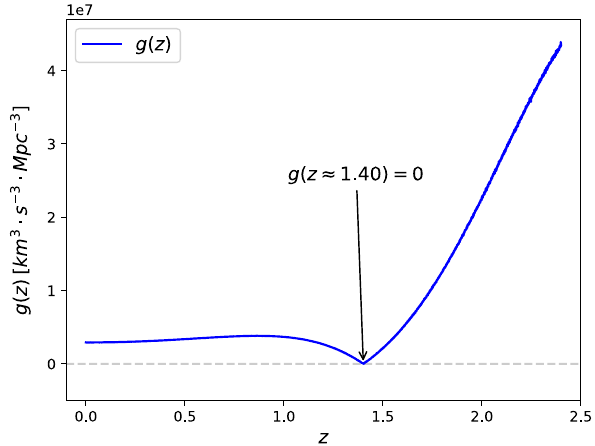
Fig. 6 Distribution of the redshift of the D-B point. The black line is the probability density of a best-fit normal distribution. The mean value of the distribution is z D-B ≈ 1 . 4026 and the standard deviation is σ ≈ 0 .